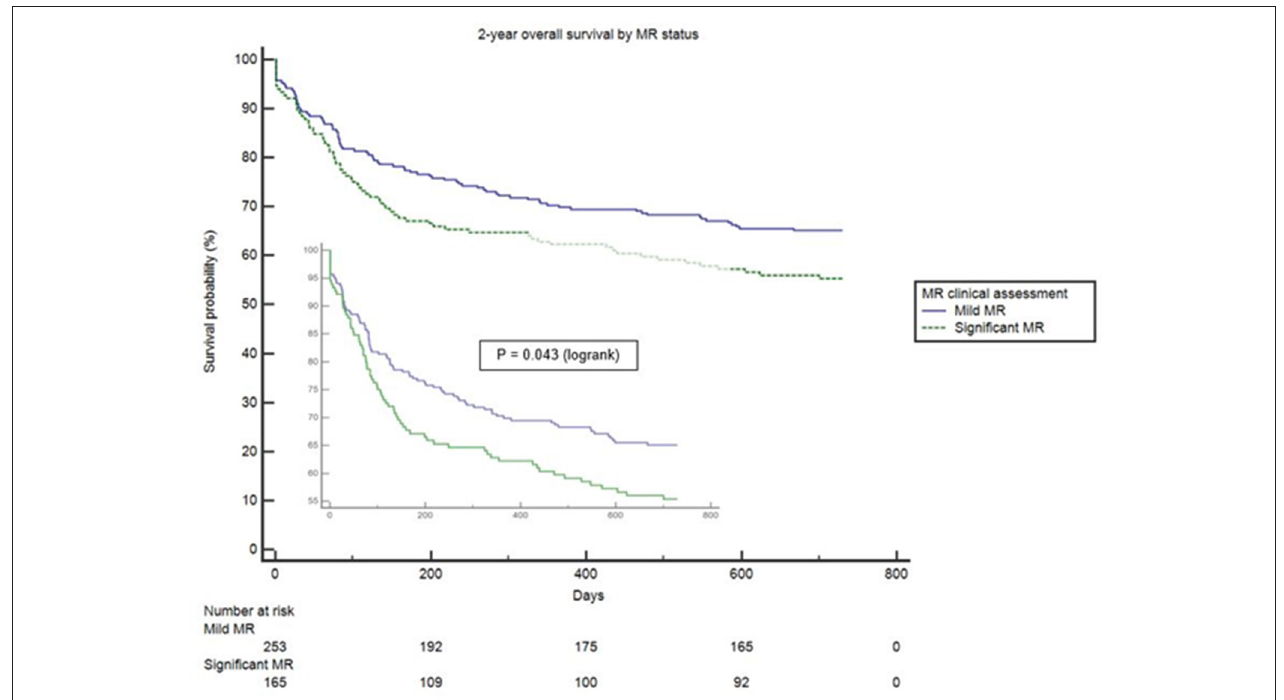
FIGURE 1 | Unadjusted survival curve of 2-year all-cause mortality comparing mild and significant MR.